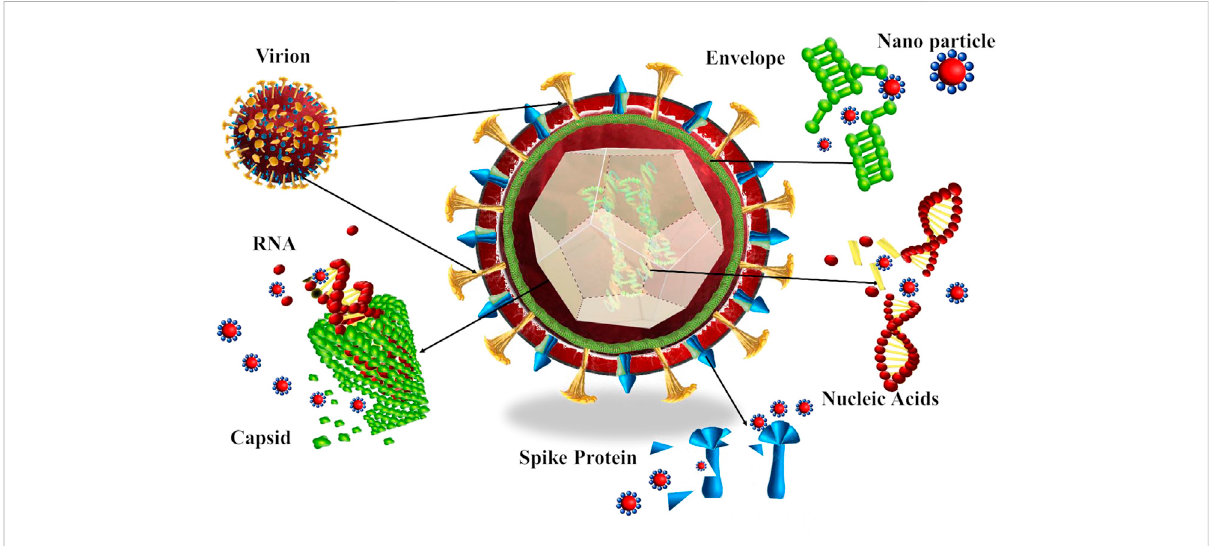
FIGURE 1 Antiviral mechanism of typical metal nanoparticles. Viruses generally infect the host cell through four mechanisms: 1. attachment to the host cell, 2. penetration, 3. viral replication, and 4. budding. The metallic nanoparticle inactivates viruses by attachment to the virus, inhibiting the attachmentvirustothehostcell,damagingthepeptidoglycanbonds,increaselevelsofH2O2,O2-orOH-,whicharereactiveoxygenspecies(ROS), binding to the spike of cell in order to stop attachment, destruction of cell structure, functional and structural proteins, destruction of nucleic acid and promote host immune system to inhibit the spreading and budding of the